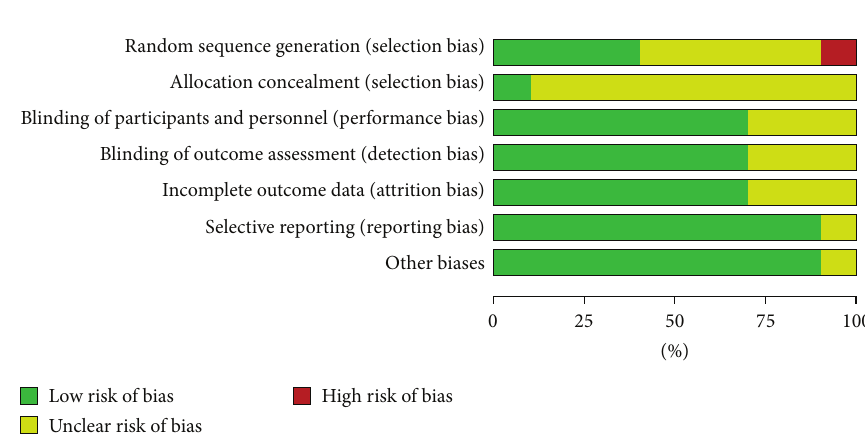
Figure 2: Risk of bias assessment for studies meeting inclusion